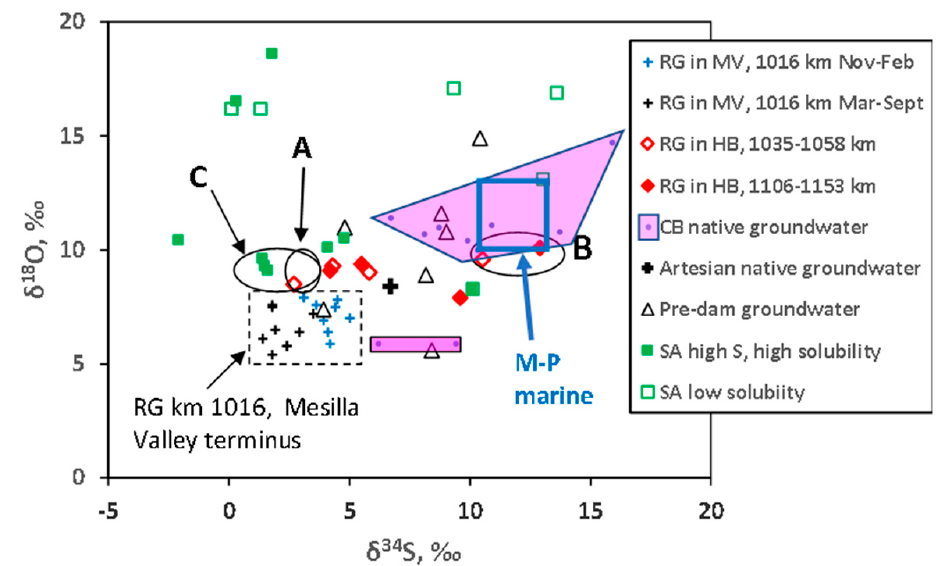
Figure 8. Plot of δ 18 O SO4 vs. δ 34 S, showing available data for Rio Grande, RG, surface water and groundwater in the Hueco Bolsón (HB) from this study and [11,18] in relation to data at km 1016 near the terminus of the Mesilla Valley (MV) from [10] (site 20) and high-sulfur soil amendments (SA) from this study and [10]. RG = Rio Grande (locations shown as km from the source); CB = Central Basin; M-P marine = Middle Permian marine sulfate [40]. A, B and C correspond to end- members shown in Figure 7.